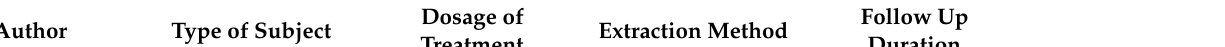
Table 1. Effect of I. batatas on hyperglycemic